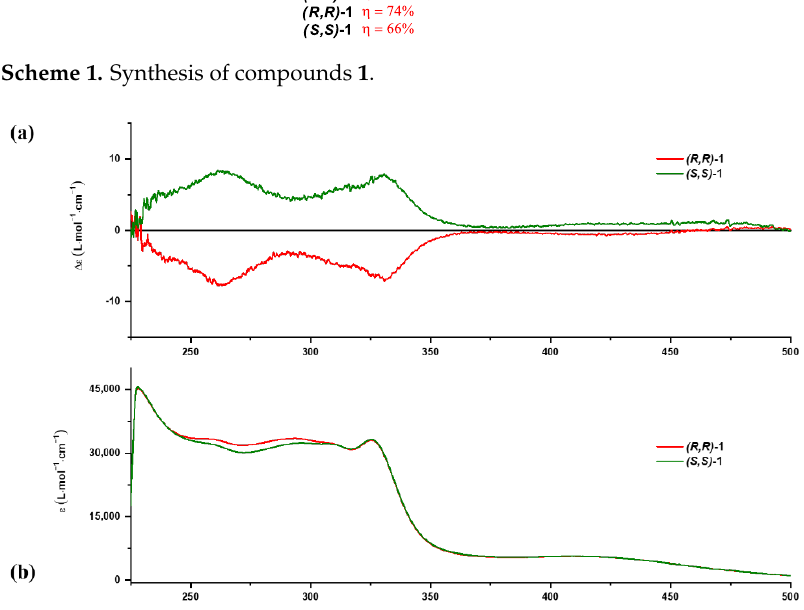
Figure 2. CD ( a ) and UV-Vis ( b ) spectra of compound 1 pair of enantiomers. Green line: ( S , S ) enantiomer, red line: ( R , R ) enantiomer.